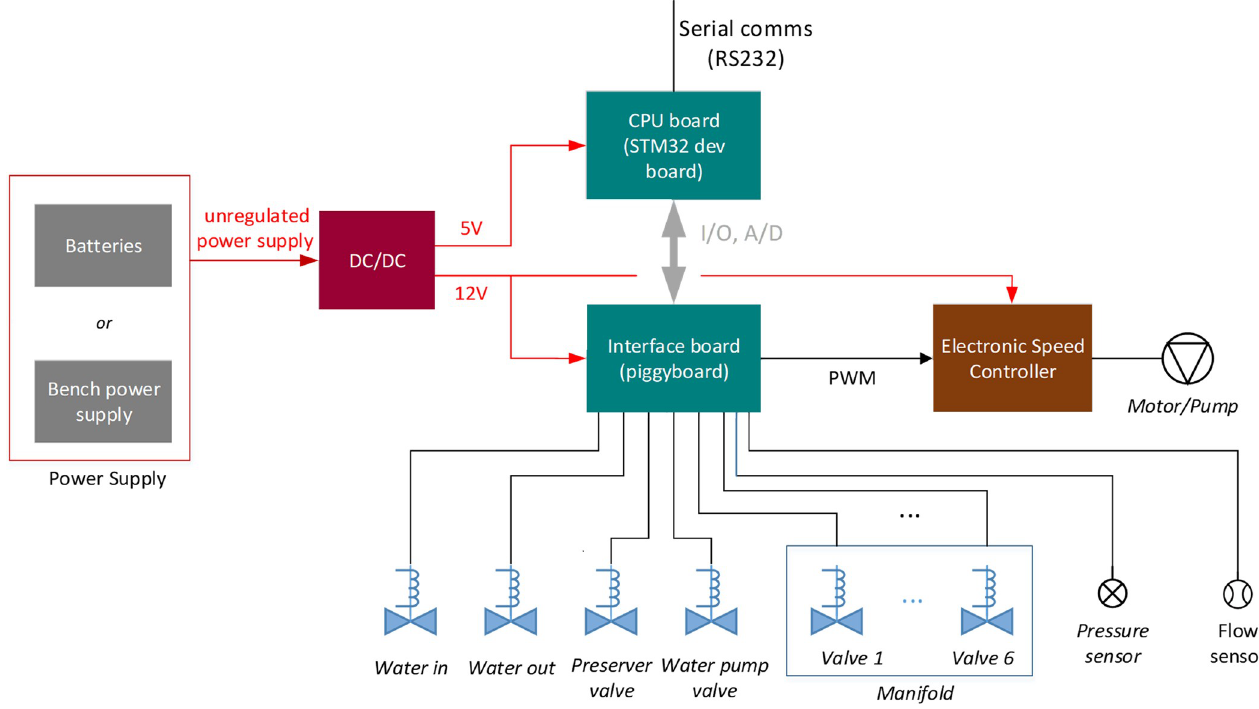
Fig 2. System control architecture. Main electronic blocks developed and how they connect to each